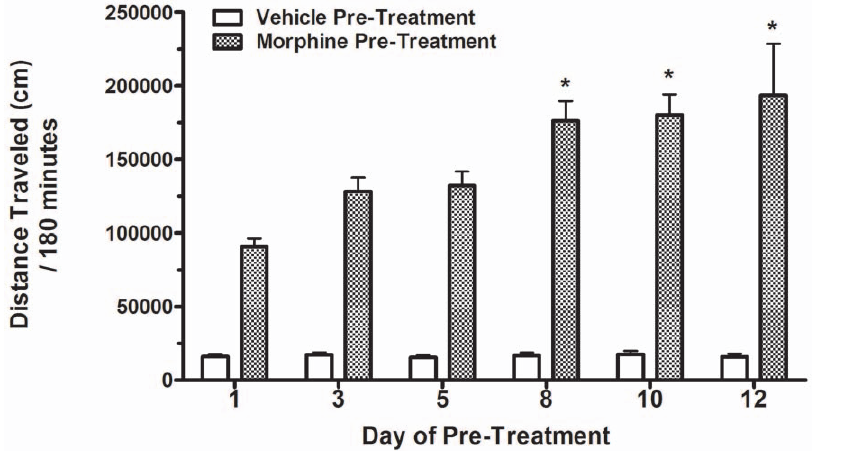
Figure 1. Intermittent morphine administration results in the development of locomotor sensitization in C57BL/6 mice. Mice were given either a saline (10 mg/ml) or morphine (10 mg/kg) injection on days 1, 3, 5, 8, 10, 12 and a locomotor activity test was conducted and recorded immediately after each injection for 180 min. Data are recorded as total distance traveled for 180 min and shown as total distance traveled (cm) 6 S.E.M in each treatment group (n=8–16 mice per group). * P , 0.05 in comparison to the morphine treated group’s first day of